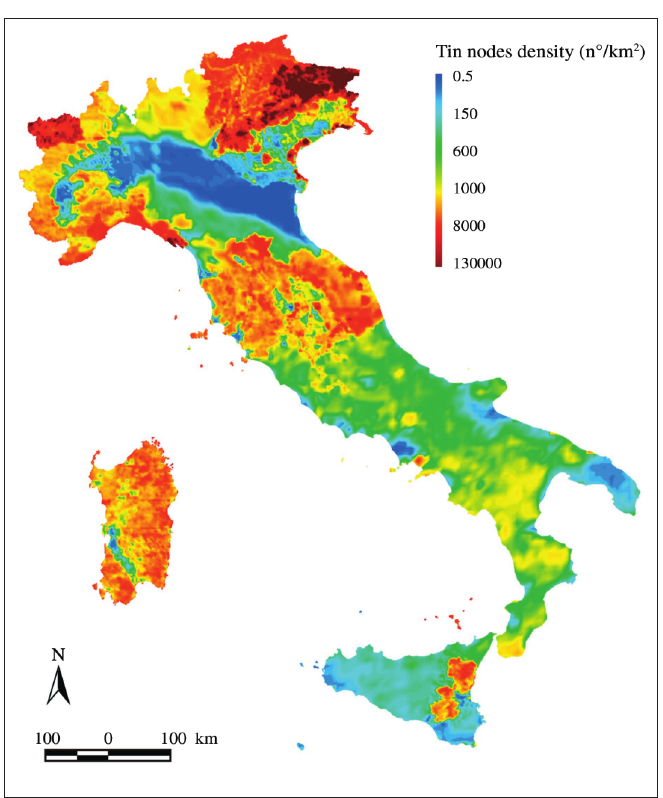
Fig. 6. The node density of the TINITALY/01 database has been derived triangulating the number of nodes per km 2 of all the tiles. Note the uneven distribution over the Italian territory. The resolution of the original input da- ta source (fig. 2) clearly exerts a strong control on the TIN node density distribution. The number of TIN trian- gles is roughly twice the number of TIN nodes all over the model, so values reported on the scale bar of the fig- ure can be directly converted to obtain the local average TIN triangle